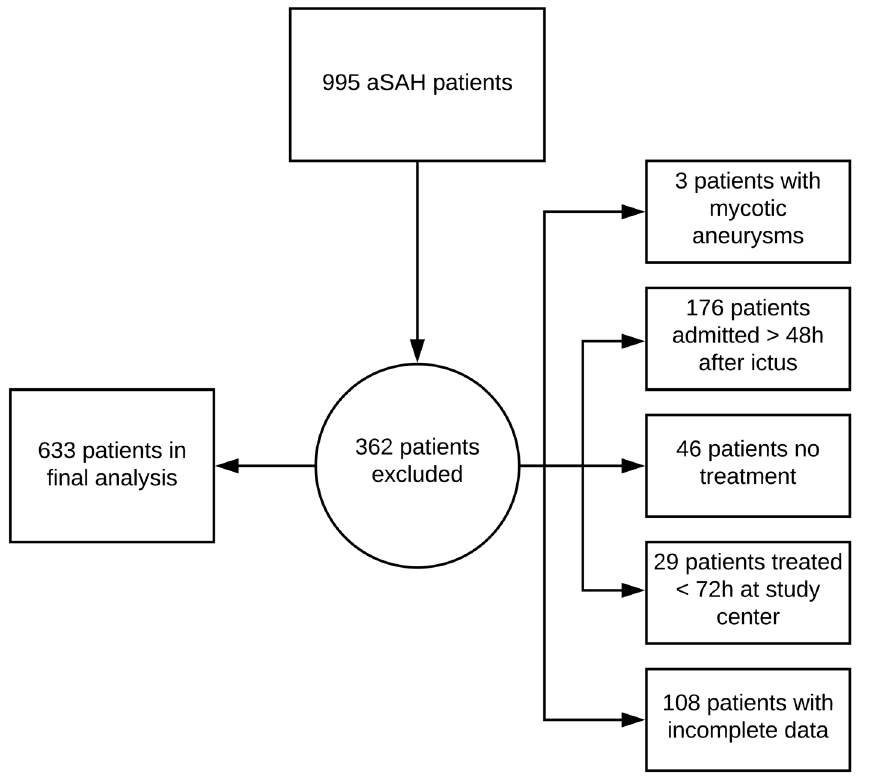
Figure 1. Flow-Chart of recruitment process for this study.